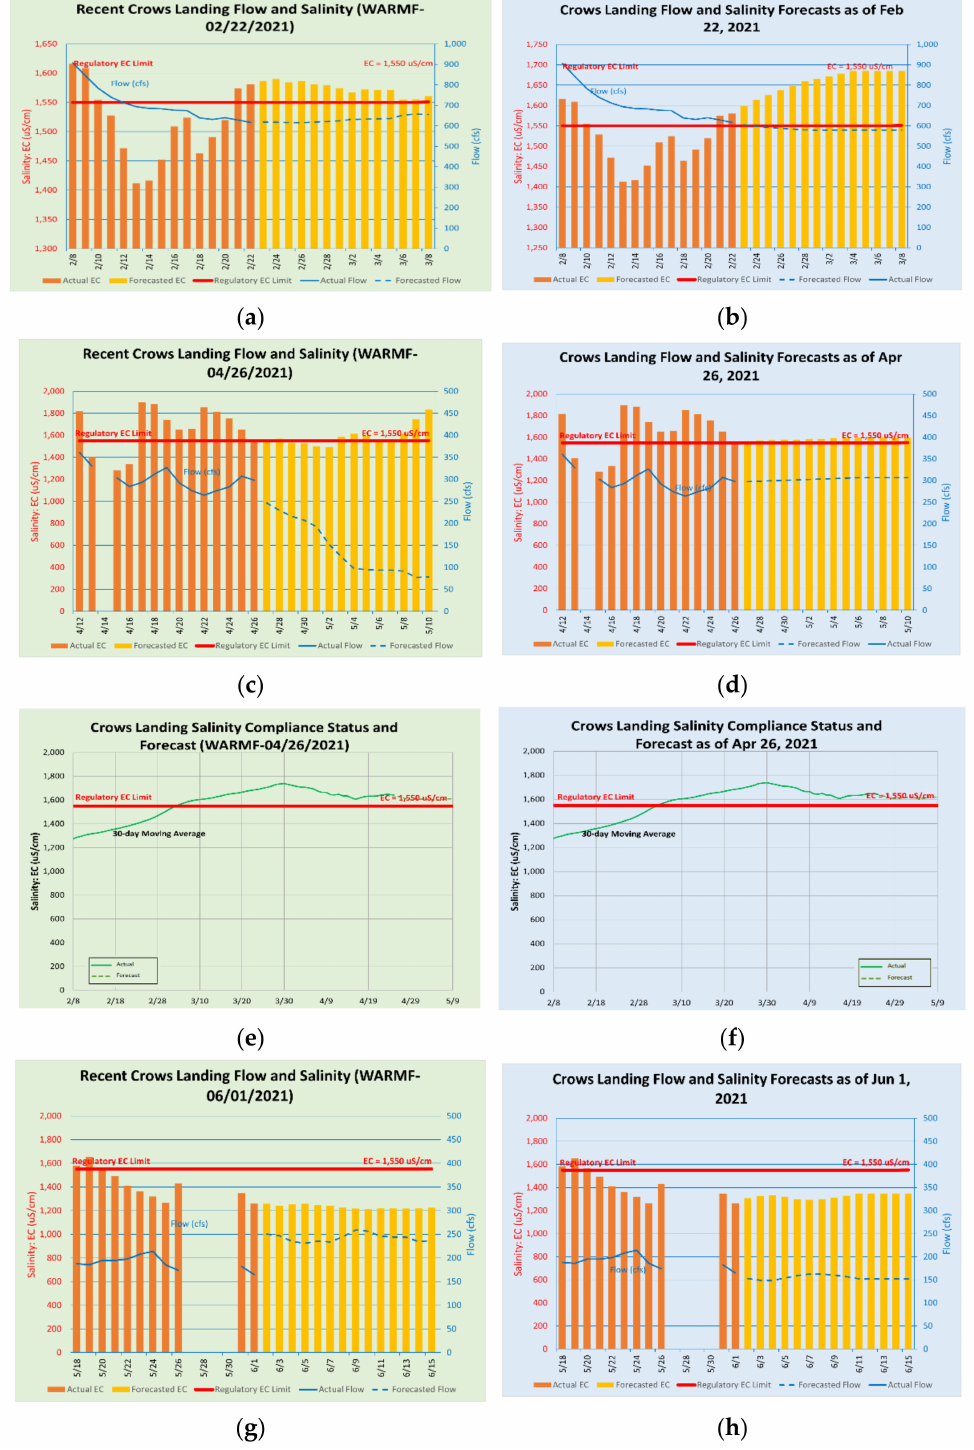
Figure 18. Comparison of daily WARMF and Regression model forecasts for EC at the Crows Land-ing compliance monitoring station on 22 February 2021 ( a,b ); 26 April 2021 ( c,d,e,f ); and 1 June 2021 ( g,h ). Graphs ( e,f ) show the 30-day running average EC forecast on 26 April 2021 relative to the the 30-day running average EC compliance objective. Conversion of flow in cfs to m3/s: 100 cfs = 2.83 m 3